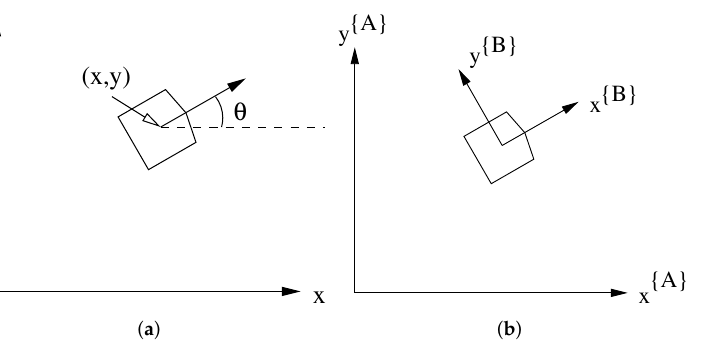
Figure 3. Platform pose and coordinate frames used. ( a ) The platform pose is denoted by position ( x , y ) and orientation θ in a world frame; ( b ) the relationship between the world coordinate frame { A } and the platform coordinate frame { B } .